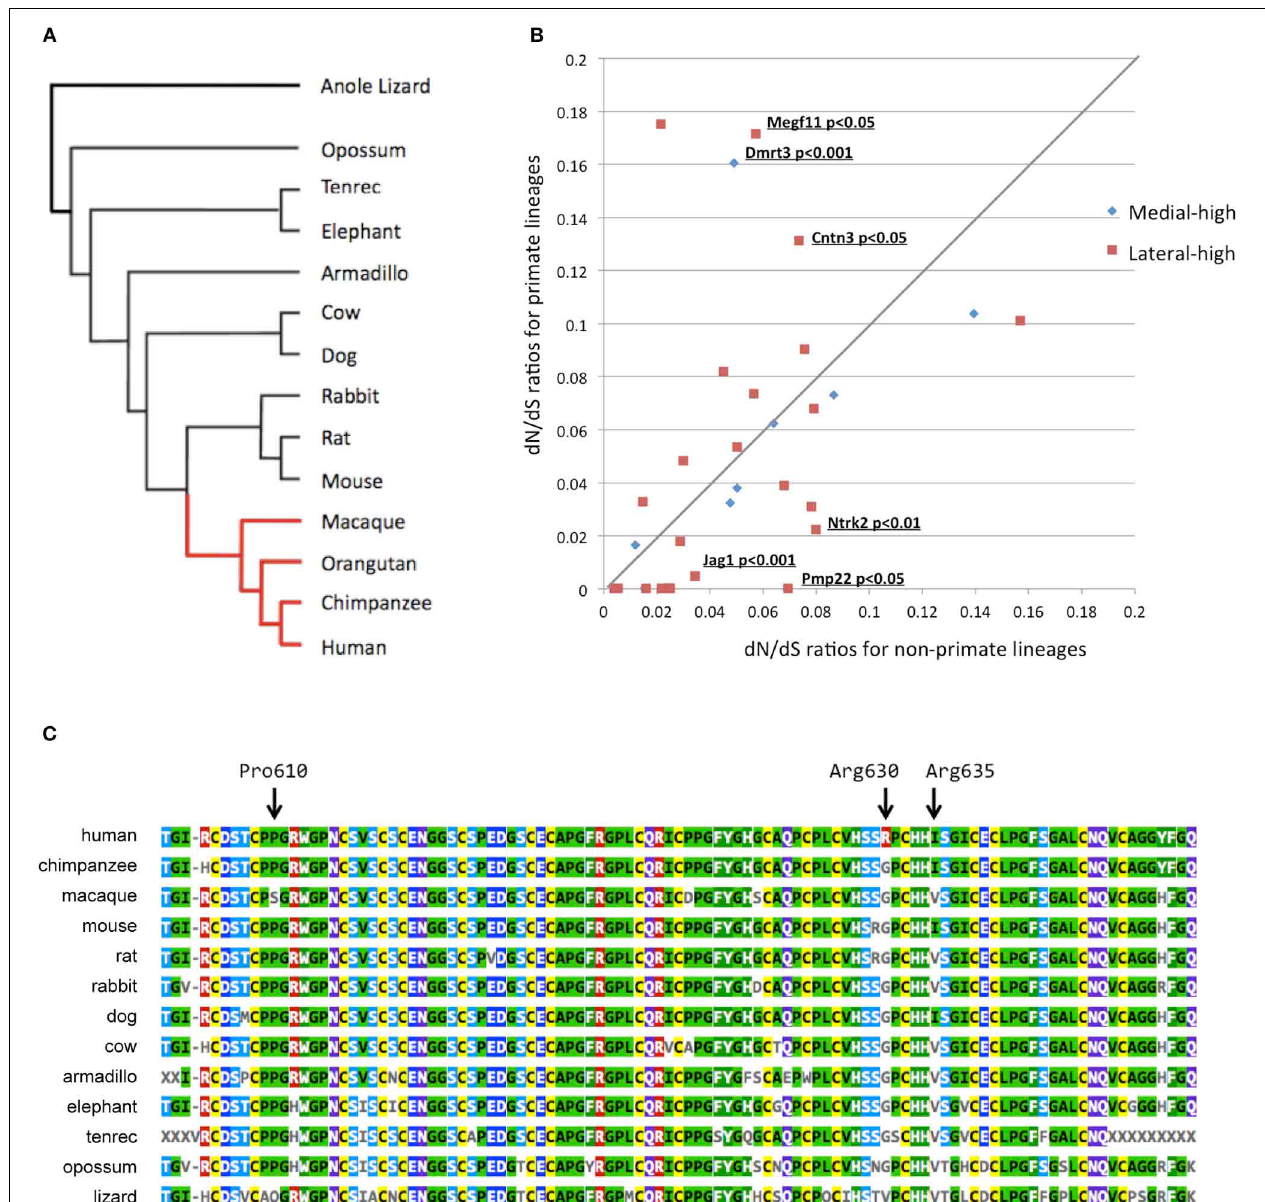
lineages with a significance level of 0.05. (C) Alignment of the Megf11 protein sequences in 13 species. The orangutan Megf11 protein sequence was not included in this alignment because Ensembl did not contain any Megf11 gene annotation for the orangutan genome, possibly because of the low quality of the genome. This alignment shows that Arg630 is a human-specific residue while the amino acid site is strongly conserved among mammalian species, except for